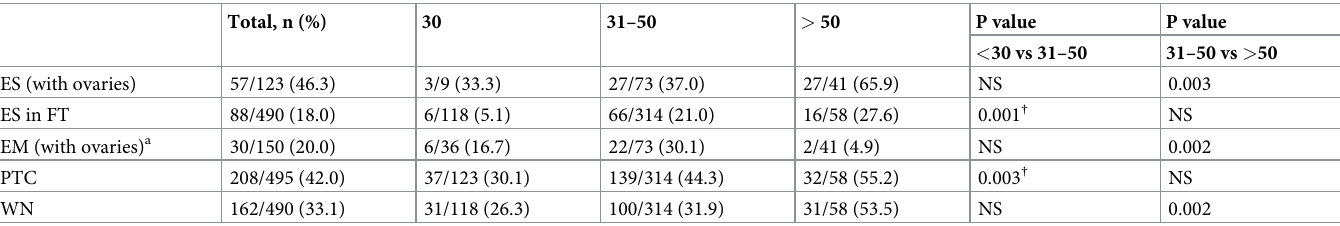
Table 3. Prevalence of benign lesions stratified by age. (Chi square